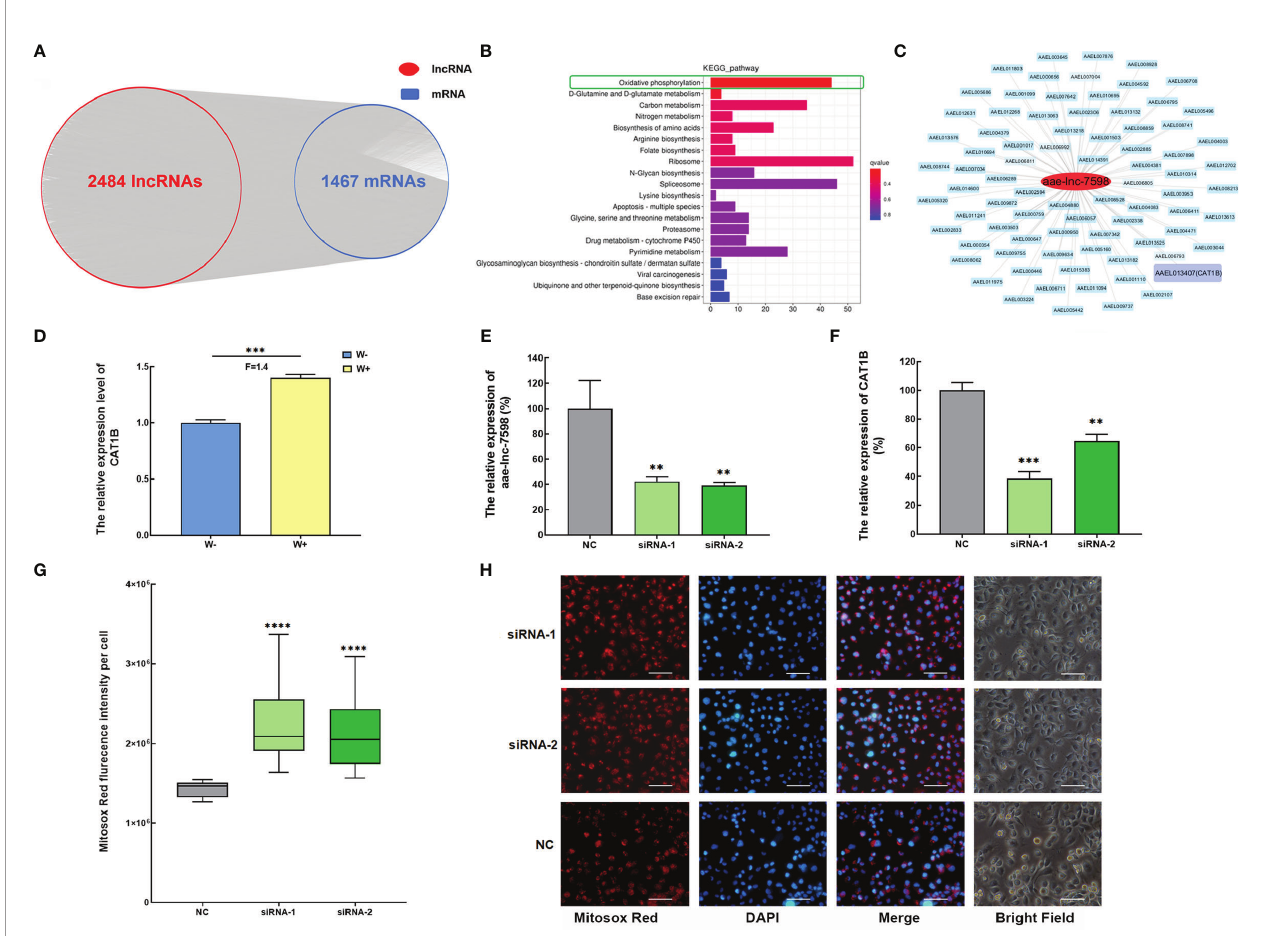
FIGURE 2 | Wolbachia induces aae-lnc-7598 to mediate trans -regulation of the antioxidant catalase 1B gene to balance intracellular ROS stress in A. aegypti . (A) The co-expression network of DE lncRNA-mRNA via trans -regulation mechanism. (B) KEGG pathway enrichment analyses of DE lncRNA via trans -acting. (C) The co-expression network of aae-lnc-7598. The red circle represents aae-lnc-7598, while the blue rectangle represents mRNA. Among them, the purple rectangular represents the CAT1B gene. (D) The relative expression level of CAT1B in W-Aag2 (W+) and Aag2 cells (W-). (E) The relative expression of aae-lnc- 7598 at 72-hour post transfection. (F) The relative expression of CAT1B gene at 72-hour post transfection. (G) The fl uorescence intensity of mitochondrial ROS per cell at 72-hour post-transfection using the Mitosox Red probe. The bar represents the range of maximum and minimum value, and the horizontal shows the median. NC represents W-Aag2 cells transfected with siRNA control; siRNA-1 and siRNA-2 represent the aae-lnc-7598 depleted W-Aag2 cells obtained by transfection with two individual siRNAs of aae-lnc-7598. (H) Representative image of siRNA-transfected W-Aag2 cells at ×40 magni fi cation. The mitochondrial ROS and nucleus were stained with Mitosox Red probe (red) and DAPI (blue). The white line indicates 50 micrometers; **** P < 0.0001; *** P < 0.001; ** P < 0.01. F means fold